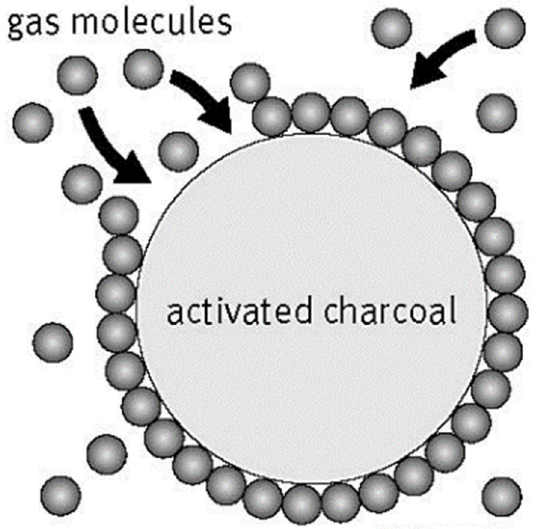
Figure 1. Illustration of adsorption of adsorbate onto adsorbent.